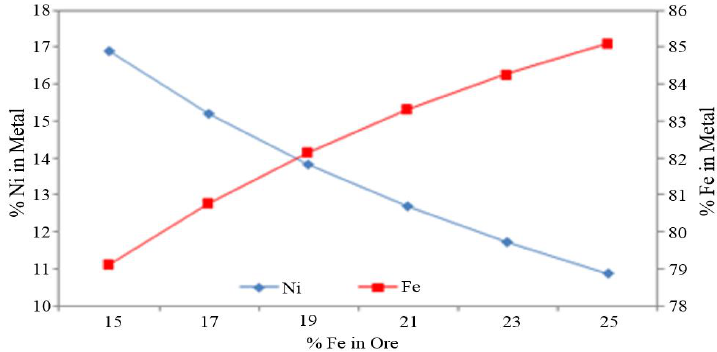
Figure 6. Effect of Metal Composition when Fe Composition Increases.